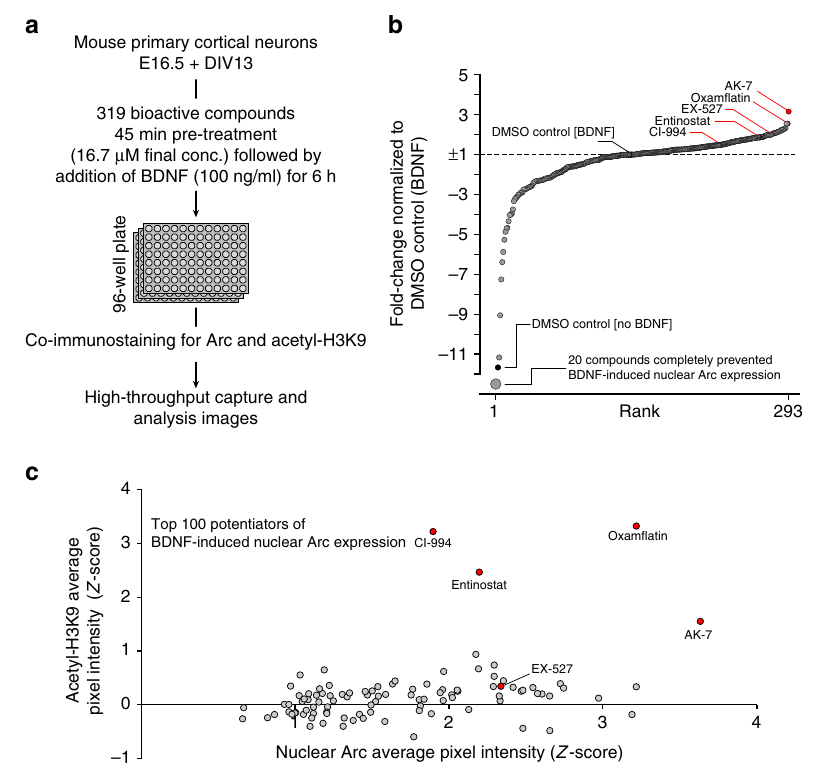
Fig. 3 Screen for modulators of BDNF-induced Arc expression and histone acetylation. a Screen setup and technical details. b Waterfall plot of 293 screen compounds for which reliable data was collected at the tested concentration. Highlighted as red dots are KDAC inhibitor compounds that increased abundance of nuclear Arc. Data are presented as fold-change normalized to DMSO control plus BDNF ( ± 1-fold-change, dashed line). c Joint representation as a Z -score of the acetyl-H3K9 and Arc immuno fl uorescence signals measured in neuronal nuclei for the top 100 potentiators of BDNF-induced Arc